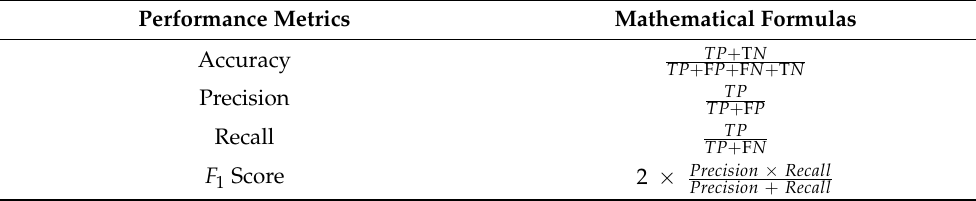
Table 4. Performance